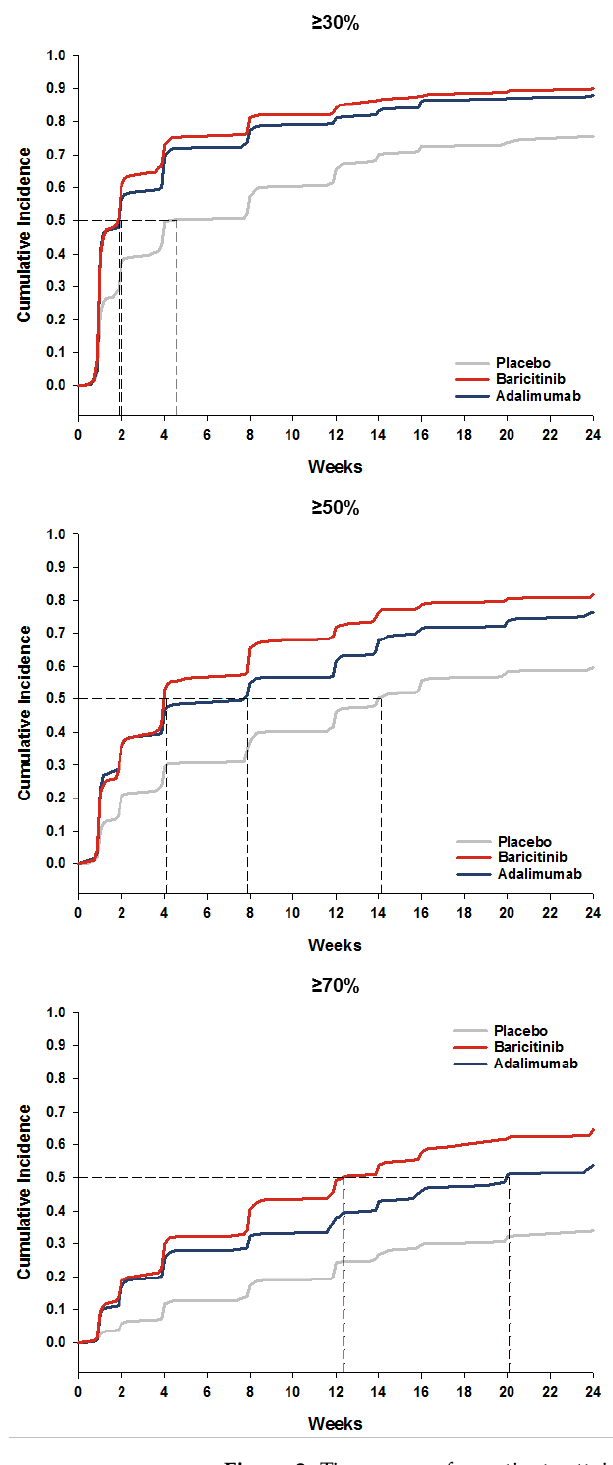
Figure 2. Time course for patients attaining pain relief thresholds.